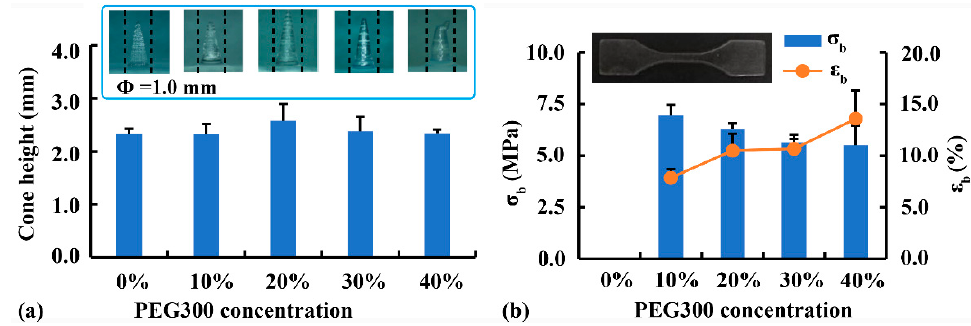
Figure 9. Effect of PEG300 concentration on ( a ) the printability of fine structures and ( b ) the mechanical properties of printed materials.